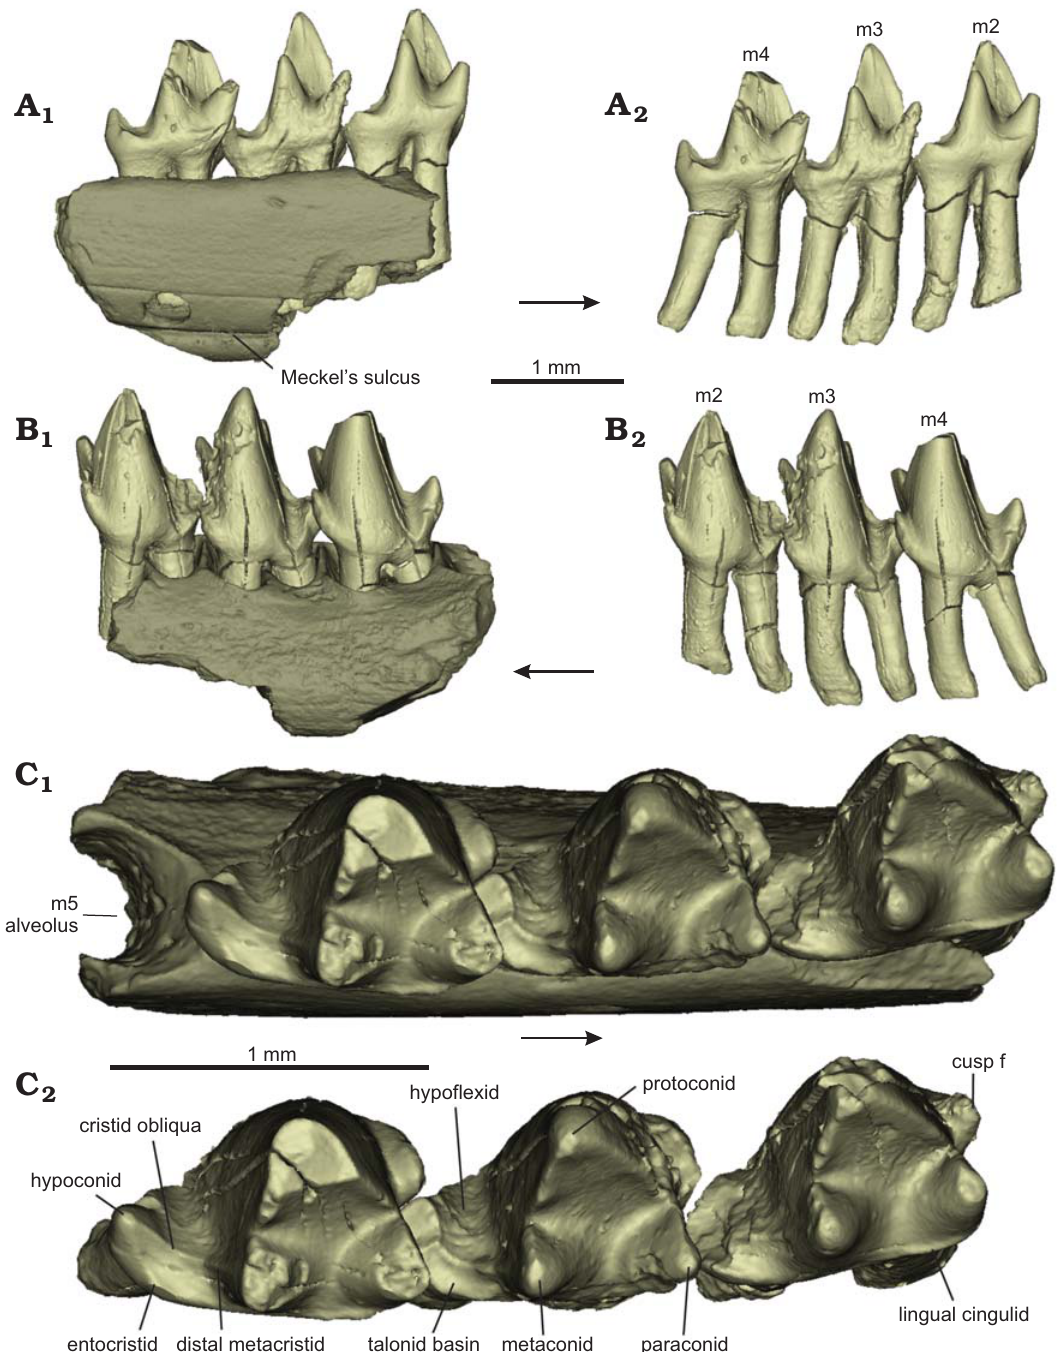
Fig. 1. Amphitheriid mammalian Palaeoxonodon ooliticus Freeman, 1976b (NMS G.1992.47.123) from the Kilmaluag Formation, Bathonian, in lingual ( A ), buccal ( B ), and occlusal ( C ) views; partial left dentary (A 1 –C 1 ); dentition only (A 2 –C 2 ). Arrows indicate anterior